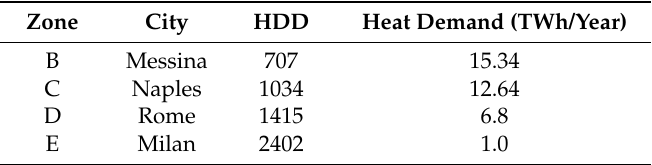
Table 2. Annual heat demands of the typical